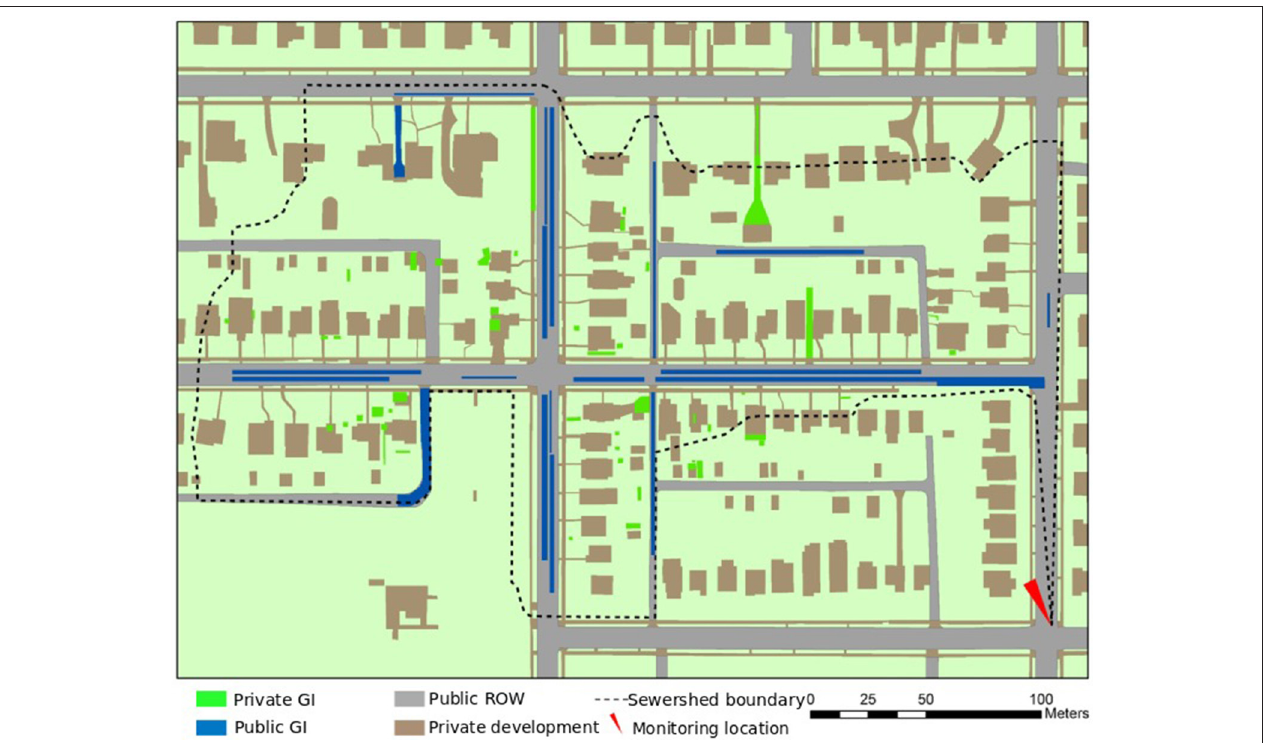
FIGURE 4 | Domain of the study sewershed with public and private installations of GI and monitoring locations. Building footprints and sidewalks are in brown; streets are in gray; pervious areas are indicated by pale green; dark blue indicates public GI projects; dark green indicates private GI projects; the red arrow points to the monitoring